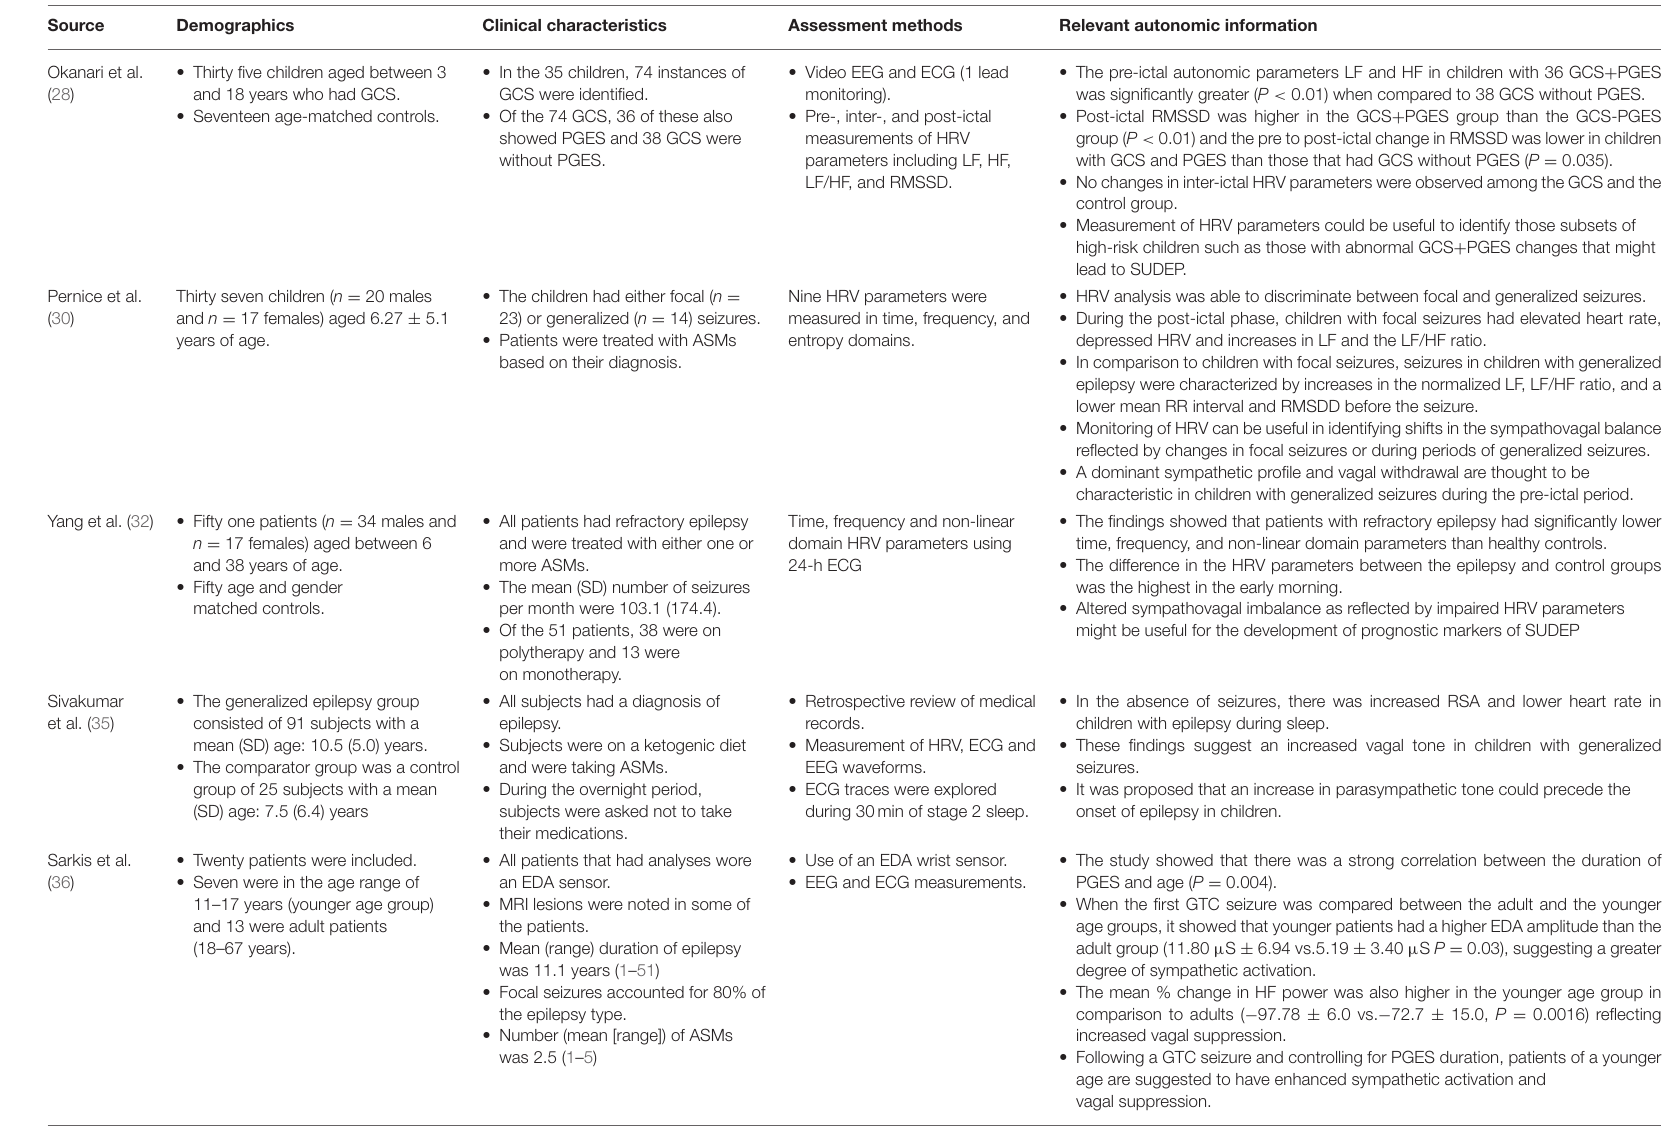
TABLE 1 | Summary of eligible studies relating to the autonomic characteristics of SUDEP.